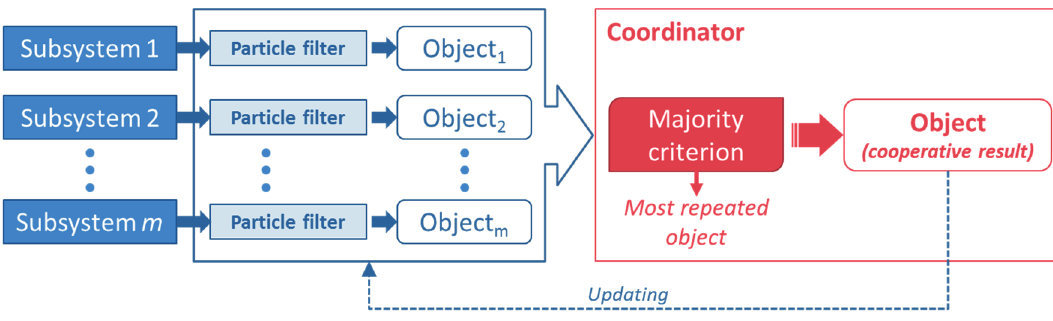
Figure 9. Particle filter implementation made by the subsystems.